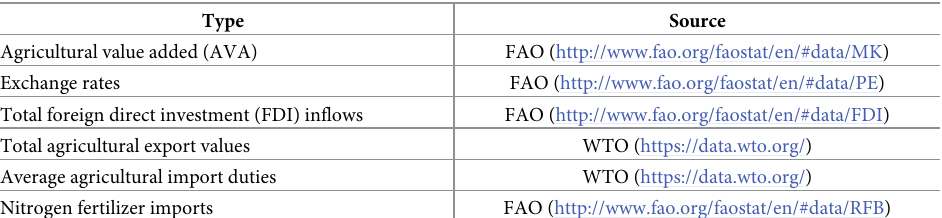
Table 1. Types and sources of data in this